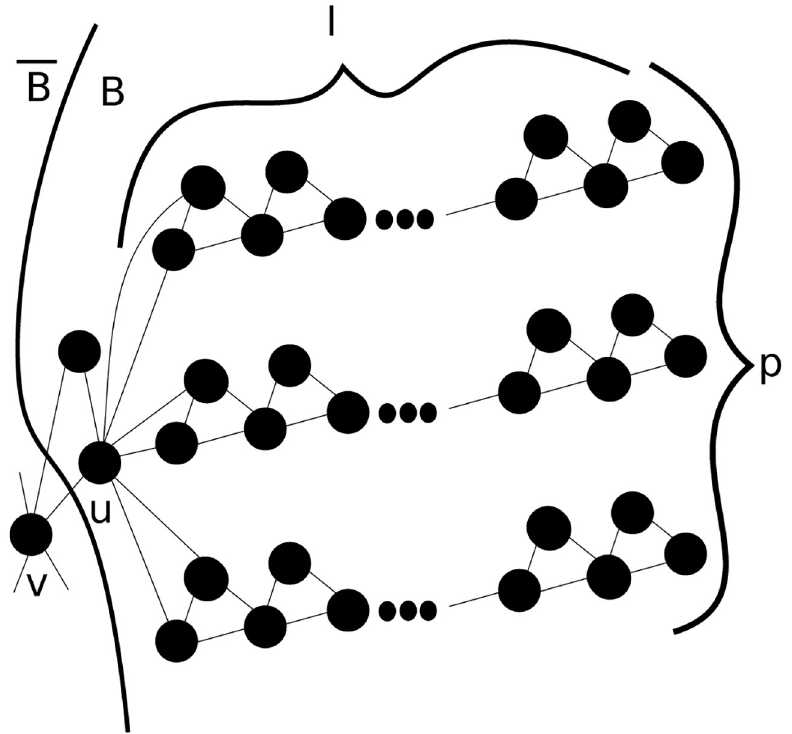
Fig 3. A generalized example to show a comparison between hypergraph CRD (HG-CRD) and higher order spectral clustering where the triangles are the hyperedges. Starting the diffusion process from node u , HG-CRD will stay more localized in cluster B and will leak flow to � B much less than higher order spectral clustering techniques by a � � factor of O p . log l